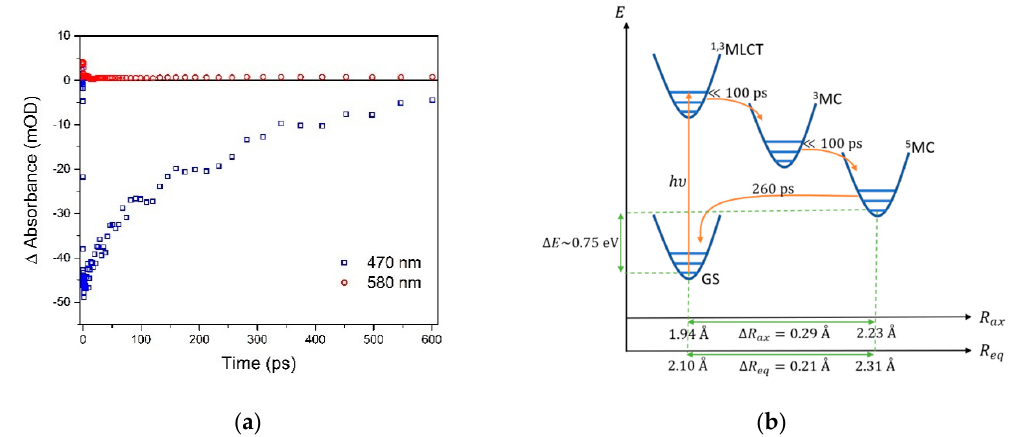
Figure 7. Photophysics of complex 2 . ( a ) Transient absorption kinetics of complex 2 following 480 nm excitation, recorded at 470 nm (blue squares) in the ground-state bleach region and at 580 nm (red circles) at the excited state absorption maximum. ( b ) Schematic representation of ground and excited state potential energy surfaces together with measured deactivation kinetics.